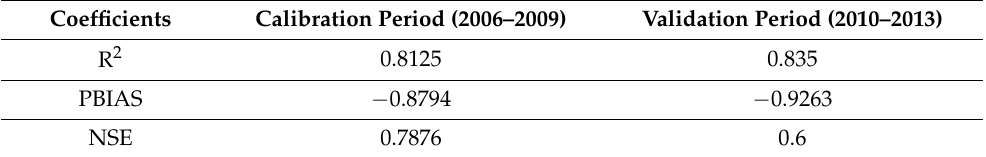
Figure 9. Simulated vs observed runoff for ( a ) calibration (2006–2009) and ( b ) validation (2010–2013) periods on monthly basis. The histogram shows difference of simulated and observed runoff values.